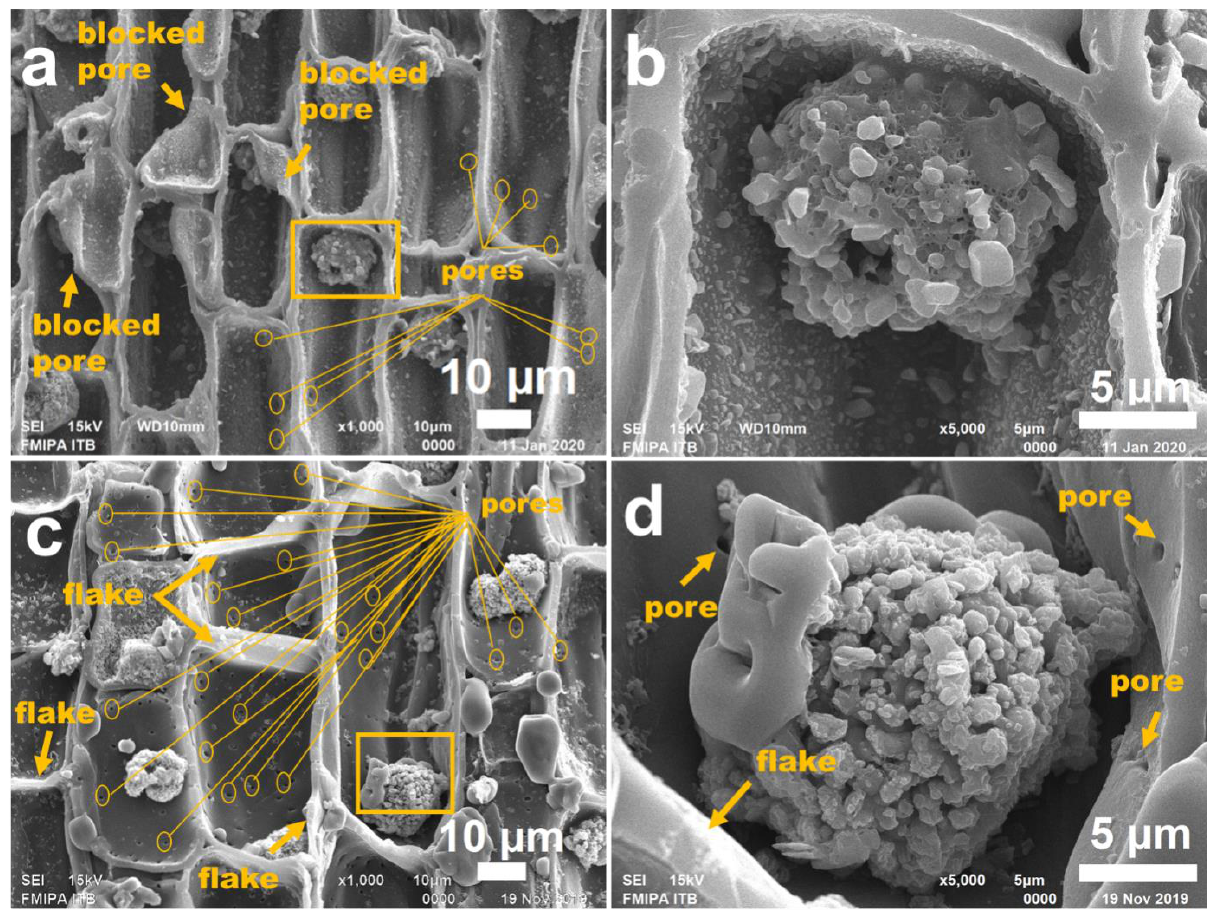
Fig. 2. SEM images of samples:. (a) HBP-1; (b) is the enlarged image of the selected region in (a); (c) HBP-3; (d) is the enlarged image of the selected region in